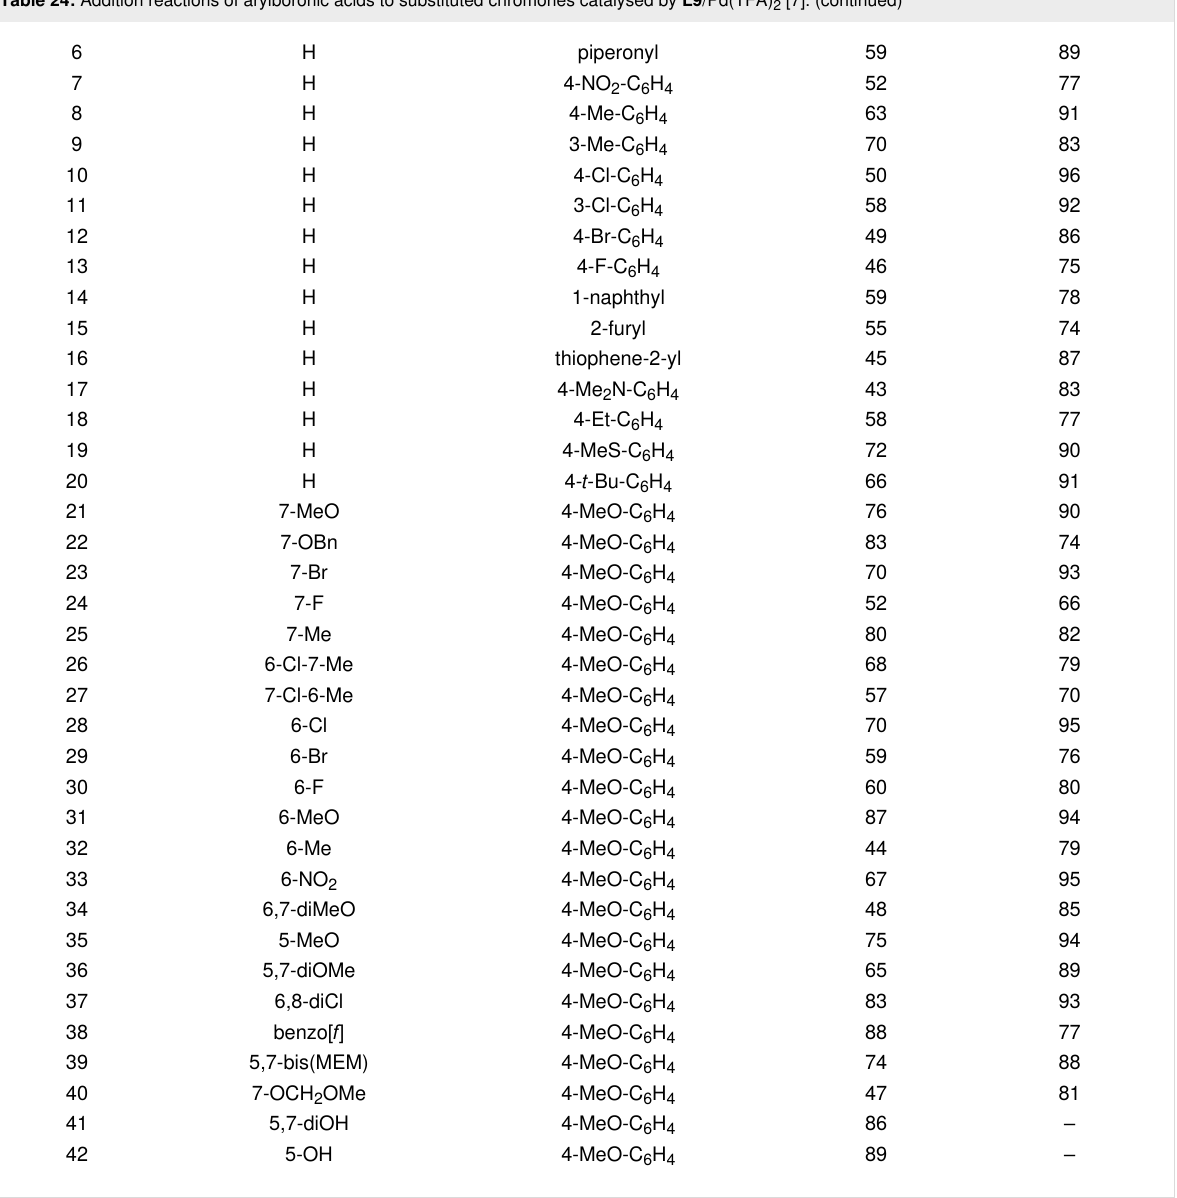
Table 24: Addition reactions of arylboronic acids to substituted chromones catalysed by L9 /Pd(TFA) 2 [7].